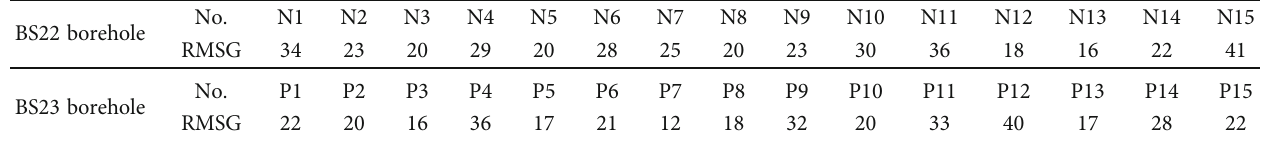
Table 7: RMSG values of the outcrops around BS22 and BS23